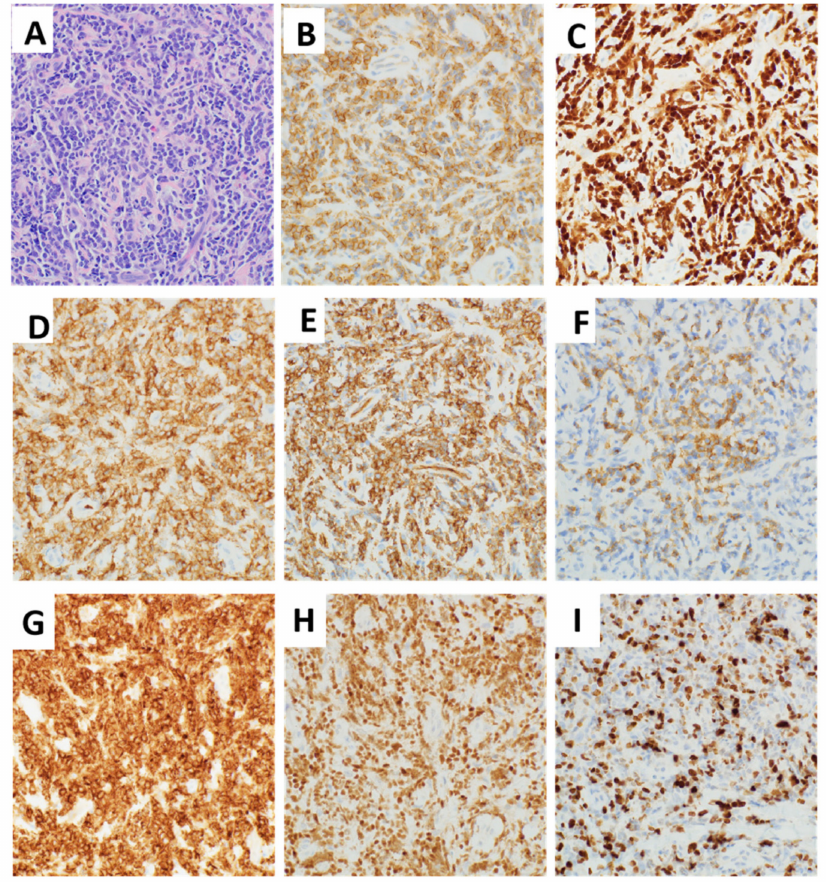
Figure 2. Histologic features of B-lymphoblastic leukemia (B-ALL) from orbital mass. ( A ) Right orbital mass biopsy demonstrating sheets of intermediate-sized immature mononuclear cells with round to irregular nuclear contours, finely dispersed chromatin, inconspicuous nucleoli, and scant cytoplasm (original magnification × 400, hematoxylin and eosin stain). By immunohistochemistry, the cells were respectively positive for ( B ) CD99, ( C ) TdT, ( D ) LCA cocktail, ( E ) CD34, ( F ) CD79a (patchy variable), ( G ) CD10, and ( H ) PAX5. ( I ) Ki-67 was 70–80% (original magnification × 400). All images were taken using an Olympus BX50 microscope and a SPOT Insight 4 camera and SPOT 5.0 advanced